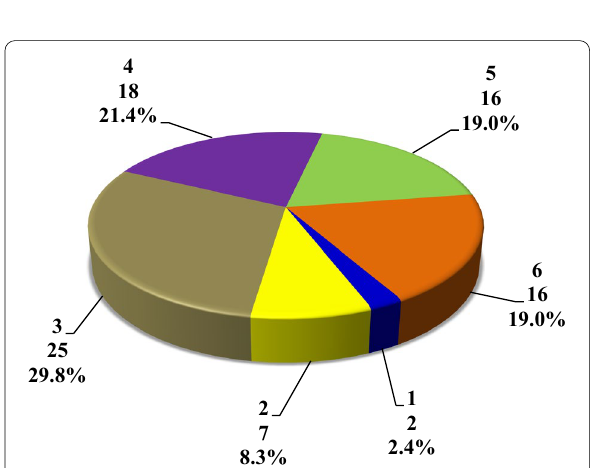
Fig. 4 Distribution of the studied cases according to multifidus muscle degeneration score (n